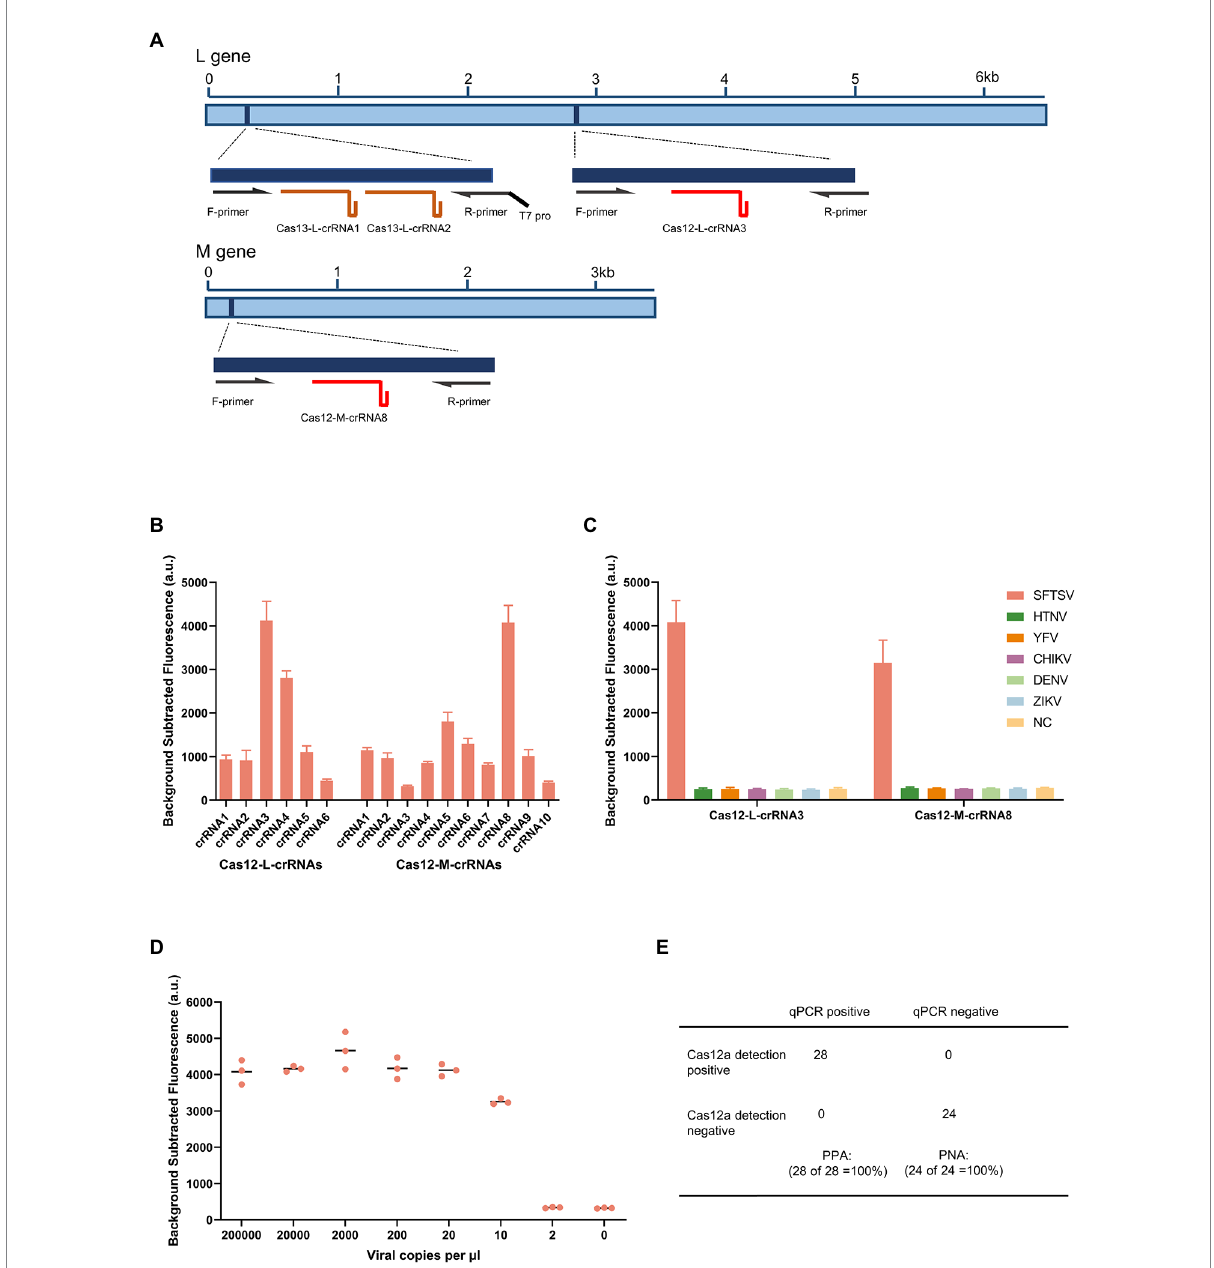
FIGURE 1 Establishment of detection method for SFTSV based on CRISPR/Cas12a. (A) Schematic diagram of the L gene and M gene of SFTSV. The gene map shows the location of selected regions, corresponding primers and crRNAs. T7 pro, T7 polymerase promoter. (B) The designed LbaCas12a-crRNAs detect the targets of L gene and M gene that were amplified using the respective primer mix. The Cas12-L-crRNA3 and Cas12-M-crRNA8 showed stronger signals using the same protocol. Values represent mean ± SD ( n = 3). (C) SFTSV, Hantaan virus, Yellow fever virus, Chikungunya virus, Dengue virus, and Zika virus were detected parallelly by Cas12-L-crRNA3 or Cas12-M-crRNA8. Only the RNA from SFTSV produced detected signals, whereas RNAs from other viruses and the negative control did not produce any change of signals. NC, no-template control. Values represent mean ± SD ( n = 3). (D) The limit of detection for Cas12a-based assay using Cas12-M-crRNA8. The diluted SFTSV RNA standards were used as detection targets ( n = 3). (E) Comparison of the clinical performance of Cas12a-based assay and qPCR assay. A total of 52 clinical samples (28 positives and 24 negatives) were evaluated using the fluorescent version of CRISPR/Cas12a assay and qPCR assay; PPA, percent positive agreement. PNA, percent negative